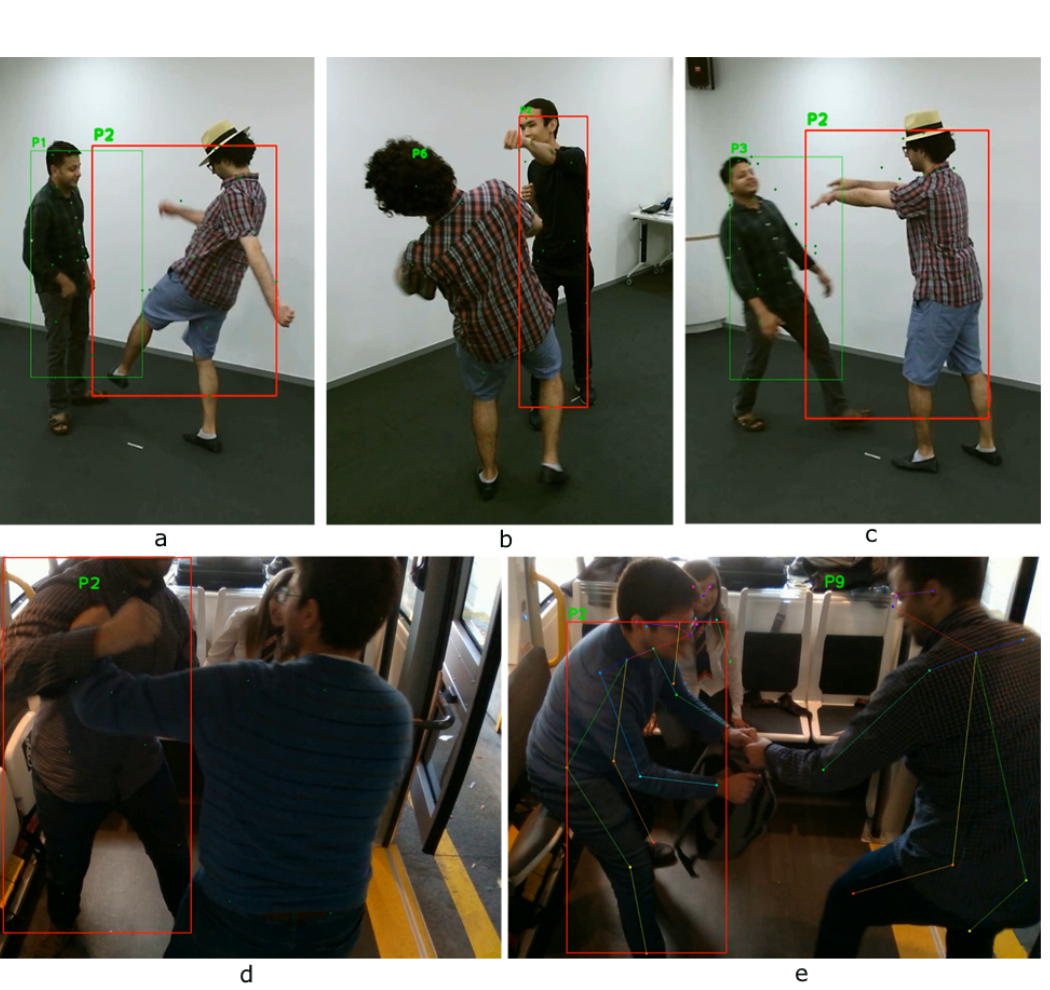
Figure 18. Evaluation on test data: ( a – c ) Abnormal event detection (violence/passengers are fighting) using different camera angles from the NTU-RGB dataset. ( d , e ) Detection of fighting/bag-snatch real-world scenarios inside the